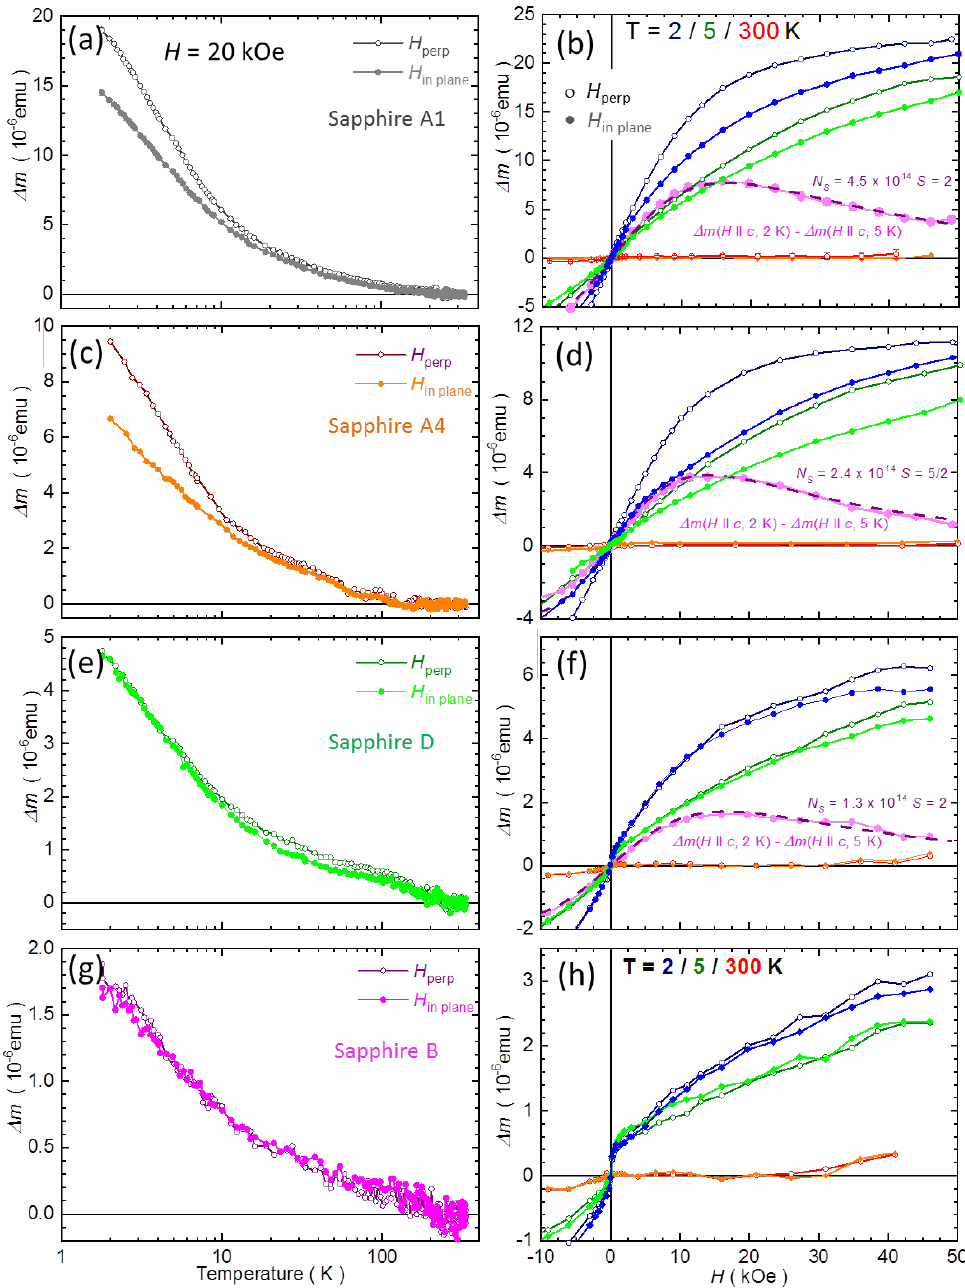
Figure 2. Results of the magnetic field H orientation-dependent studies of selected four sapphire specimens in temperature T domain (left panels) and in H domain (right panels). Each pair ( a , b ), ( c , d ), ( e , f ), and ( g , h ) presents results for one of these samples. Results in T domain are obtained at H = 20 kOe. Here, the results are normalized to correspond to a 5 × 5 × 0.3 mm 3 (~30 mg) sapphire sample, and ∆ m ( T ) = m ( T ) − m (300 K). The results in H domain are plotted after the application of a linear correction α · H , where α is the slope, of m ( H , 300 K); ∆ m ( H ) = m ( H ) − α · H . Open symbols stand for perpendicular orientation H , the closed ones represent H applied in the plane of these c -plane sapphire samples. The magenta bullets in H -panels ( b , d , f ) show the difference between ∆ m ( H perp ) measured at T = 2 and 5 K to evaluate an approximate number N S of spins S in the sample. The dashed purple lines represent the fit of difference between Brillouin functions for given S at 2 and 5 K. The possible magnitudes of N S and S yielding the best fit are given in the